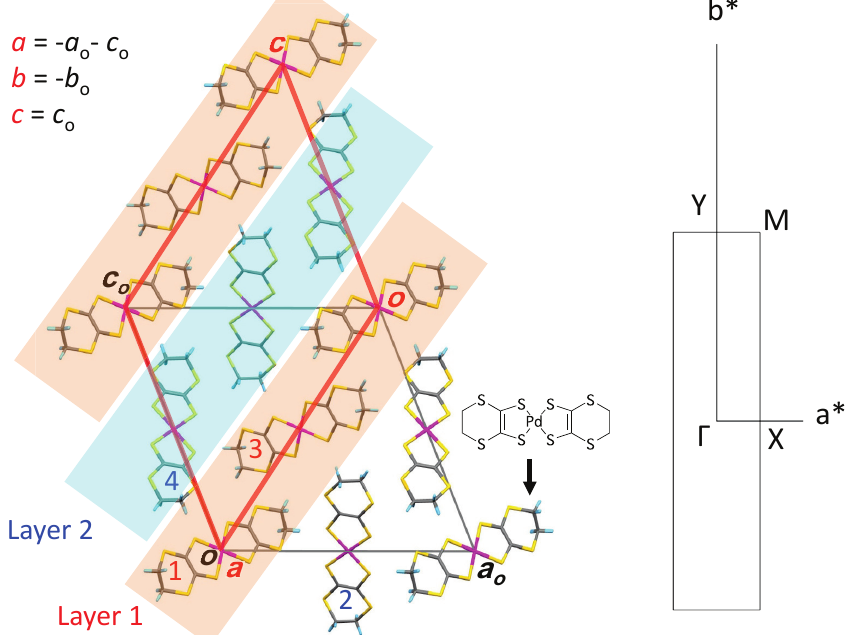
Figure 1. (Color online) Crystal structure of [Pd(dddt) 2 ] shown in the ac plane, where the molecule is stacked along the b direction perpendicular to the plane. Layer 1 (molecules 1 and 3) and Layer 2 (molecules 2 and 4) are parallel to the ab plane and alternated along the c direction. Lattice vectors a , b , and c form a new unit cell, where a is introduced for the simple representation of the energy band (see the main body). The location of the Pd atom in the unit cell is given by ( x , y , z ) = (0,0,0), (1/2,1/2,1/2),(1/2,1/2,0) and (1/2,0,1/2) for molecules 1, 2, 3, and 4, respectively. The right figure denotes the Fourier space, where a ∗ and b ∗ are reciprocal lattice vectors and Γ , X, Y, and M are TRIM (time reversal invariant